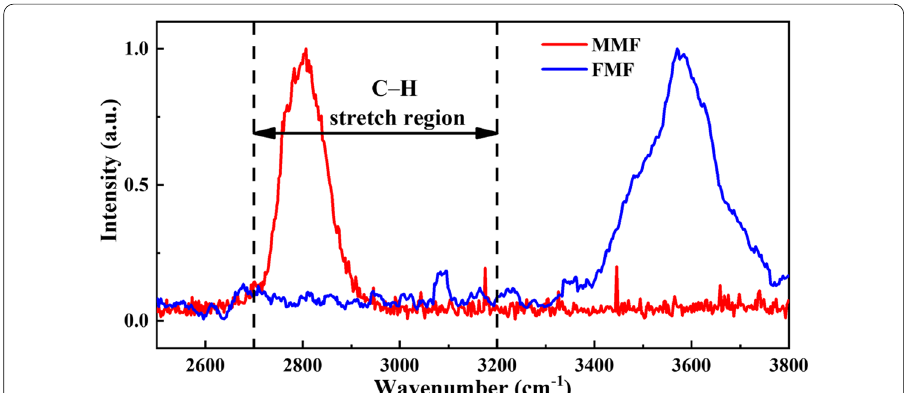
Fig.3 The FWM signals of MMF cover from ~ 2700 cm − 1 to 2900 cm − 1 and interfere with the detection of C–H bond vibrations. The FWM signals of FMF cover from ~ 3400 cm − 1 to 3800 cm − 1 and avoid